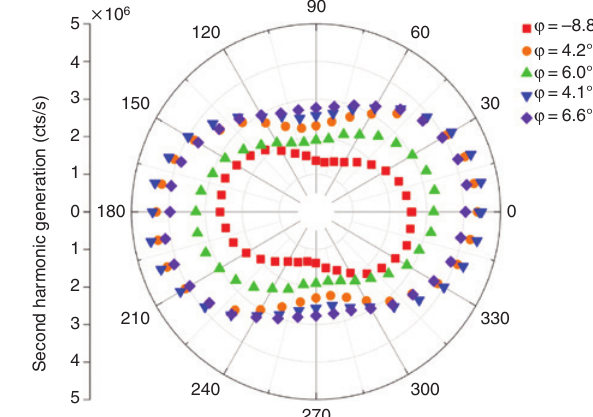
Figure 3: SHG polar plots of virtually identical nanoantennas. The tilt angle ϕ ranges from −8.8 ° to 6.6 ° .